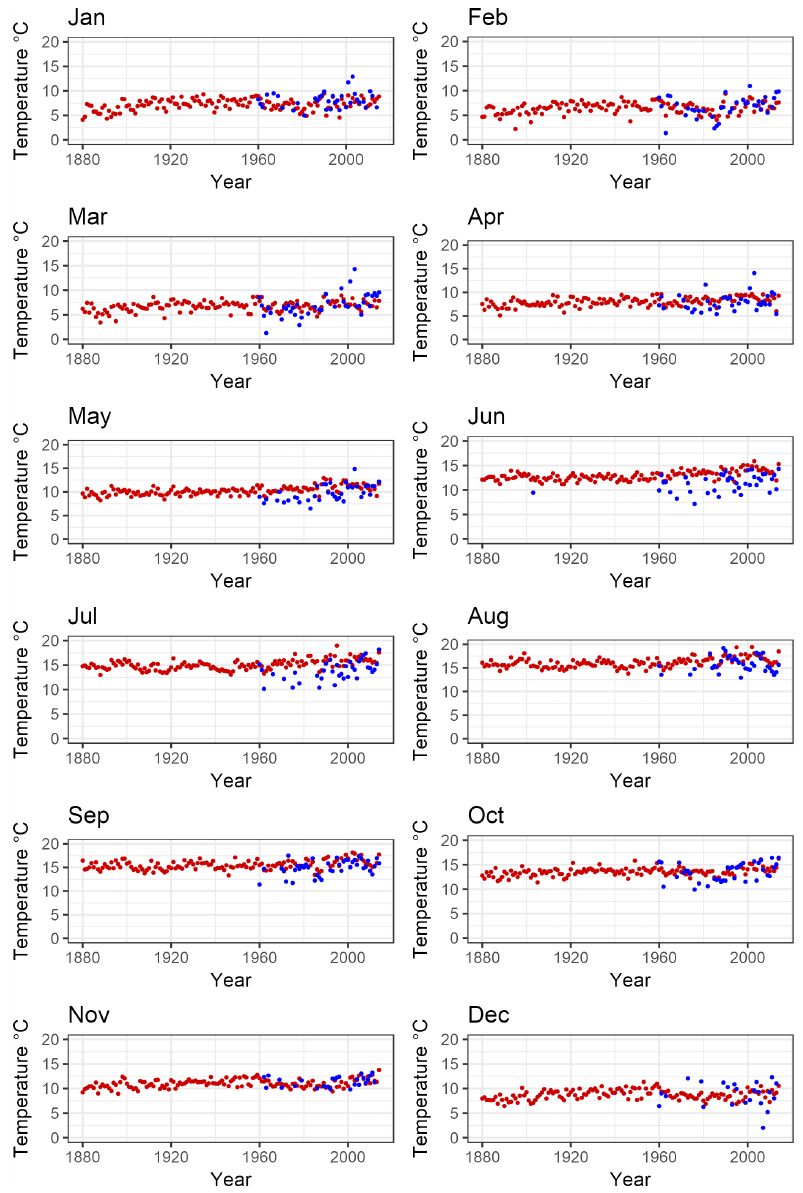
Figure 17. Average near-surface and mid-water seawater temperature around the British Isles by month from 1880 to 2015 (surface 0–5m in red, mid-water 20–25m in